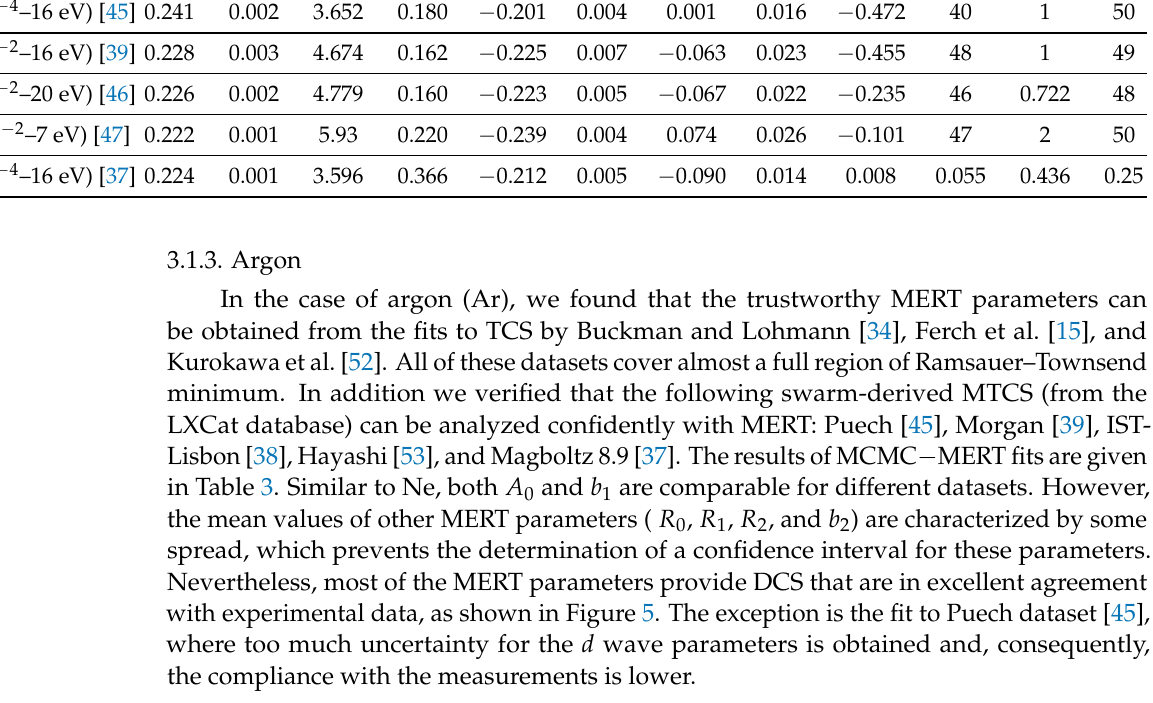
Table 3. Mean values and standard deviations of MERT parameters (appearing in the effective range approximation, Equation (10)) for e − + Ar elastic scattering. The results were calculated using the dipole polarizability α = 11.23 a 3 the effective quadrupole polarizability β = 0.0 a 5 0